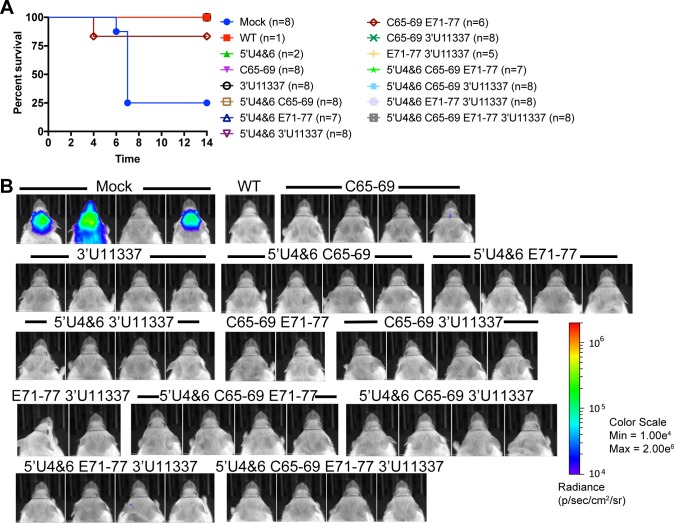
LAVs protect against high dose subcutaneous EEEV challenge.A) On day 22 post primary LAV infection, CD-1 mice that survived were challenged subcutaneously with 104–105 pfu of EEEV-nLuc TaV virus. n = number of total mice challenged from 2 independent experiments. B) IVIS images on day 6 of mice challenged with 104 pfu EEEV-nLuc TaV from a single experiment. All images are set to the same scale.